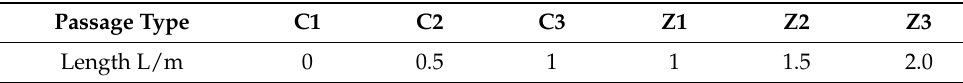
Table 1. Table Passage structure parameter